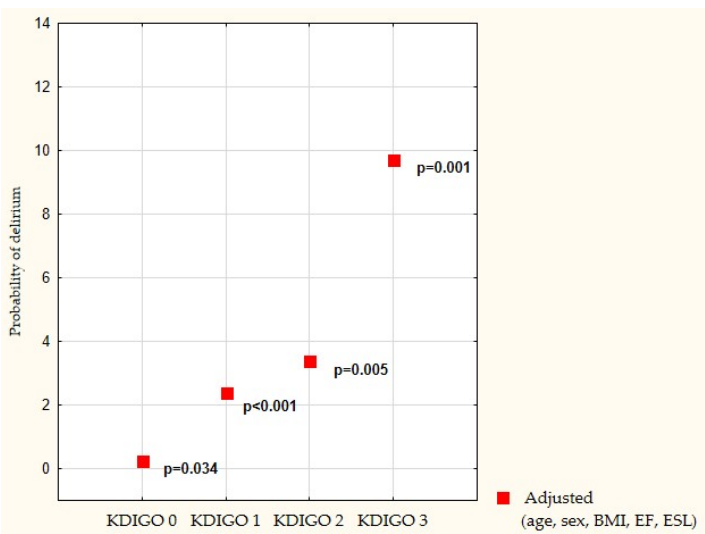
Figure 2. Risk of delirium according to adjusted and adjusted KDIGO staging. Legend: KDIGO — Kidney Disease Figure2. RiskofdeliriumaccordingtoadjustedandadjustedKDIGOstaging. Legend: KDIGO—Kidney Improving Global Outcome, BMI — body mass index, EF — Ejection fraction, and ESL — EuroScore Logistic 2. DiseaseImprovingGlobalOutcome, BMI—bodymassindex, EF—Ejectionfraction, andESL—EuroScore Logistic